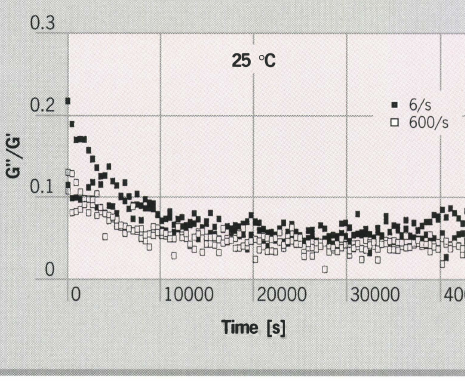
Evolution of loss (G"} to storage (G'} modulus ratio during the storage of maize starch